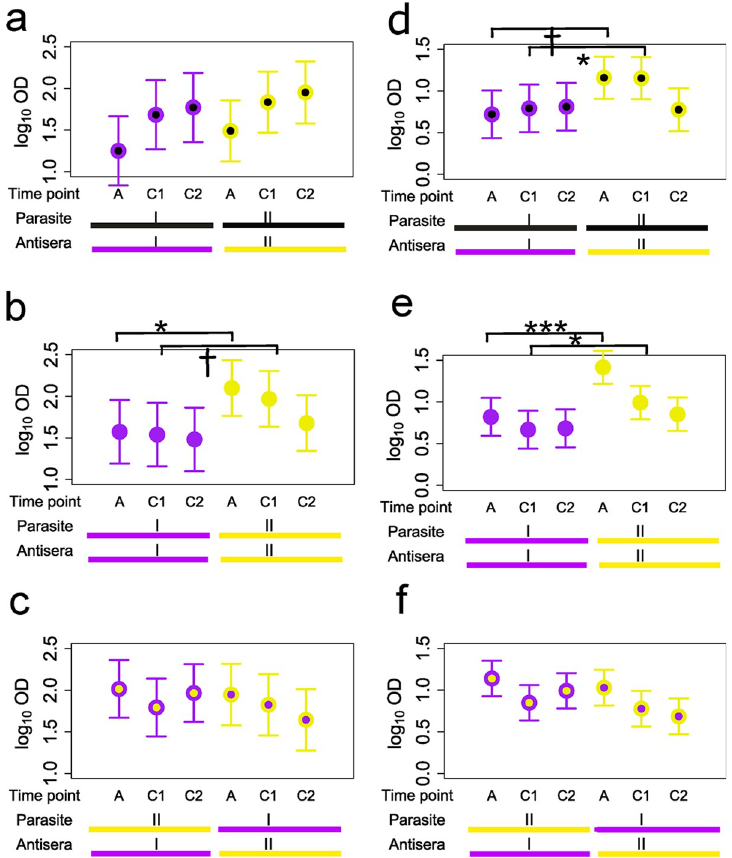
Fig 4. Effects of heterology. Each panel shows least-squares means (circles) with 95% confidence intervals (vertical bars) of IgG ( a , b , c ) and IgM ( d , e , f ) sero-reactivity for DBL α -tag antigen-antisera pairs split by timepoint and serological cluster (Antisera I and II on x-axis). In a and d , data are from antigen-antisera pairs that derive from the same host, (i.e., are homologous). In b and e , data are from antigen-antisera pairs that are heterologous with respect to individual antigens/antisera but which derive from hosts in the same serological cluster. In c and f , antigen-antisera pairs are heterologous with respect to both individual antigens/antisera and serological cluster. Colour of outer circles and lower horizontal bars below the x-axis indicate serological cluster; colour of inner circles and upper horizonal bars indicates serological cluster of the host from which the DBL α -tag antigen derived. Black inner circles and upper black horizontal bars indicate homologous antigen-antisera combinations. P-values of statistical tests for the effect of serological cluster at each timepoint are shown in black text with horizontal brackets. n.s., P > 0.05; ��� , P < 0.001.